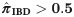
Logit-transformed proportions of highly related 2001–2014 WGS parasite sample pairs plotted with respect to inter-clinic distance.Annotations refer to site comparisons using abbreviated clinic names (MLA for Maela, 55 parasite samples; WPA for Wang Pha, 103 parasite samples; MKK for Mae Kon Ken, 4 parasite samples; and MKT for Mawker Thai, 16 parasite samples). All parasite samples were single-infection. For inter-clinic pair A and B say, the proportion was based on nA × nB parasite sample pairs, where n denotes the number of parasite samples per clinic. Error bars represent 95% confidence intervals based on bootstrapping over highly related parasite sample pair labels (equal to 1 if π^IBD>0.5 and 0 otherwise), and are therefore zero where there are no π^IBD>0.5.